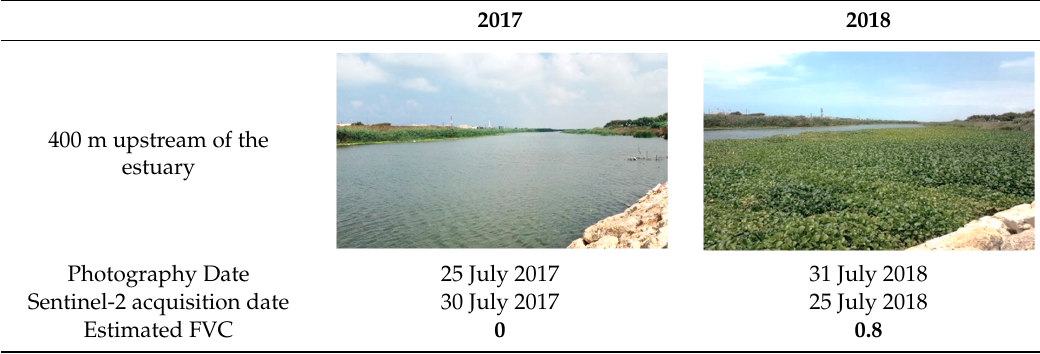
Table 5. Comparison of the development of water hyacinth observed in situ with the values estimated locally by Sentinel-2.